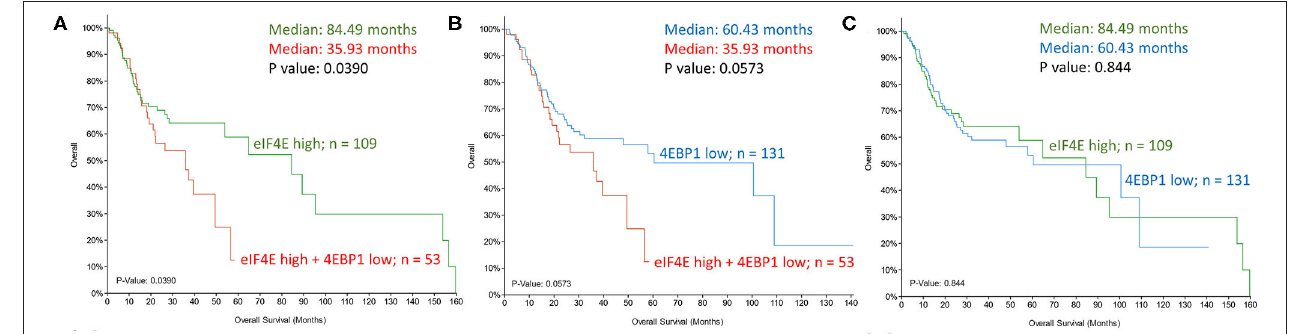
FIGURE 3 | Kaplan-Meier assessment of overall survival of head and neck cancer patients from TCGA dataset. Patients were divided into cohorts based on mRNA expression z-scores relative to all samples (log RNA Seq V2 RSEM) of (A,C) . eIF4E ( top tercile ; n = 109; green ) and (B,C) . 4EBP1 ( bottom tercile ; n = 131; blue ) were assessed and compared to patients that satisfied both criteria (increased eIF4E and decreased 4EBP1; n = 53; red ). P -values are shown.